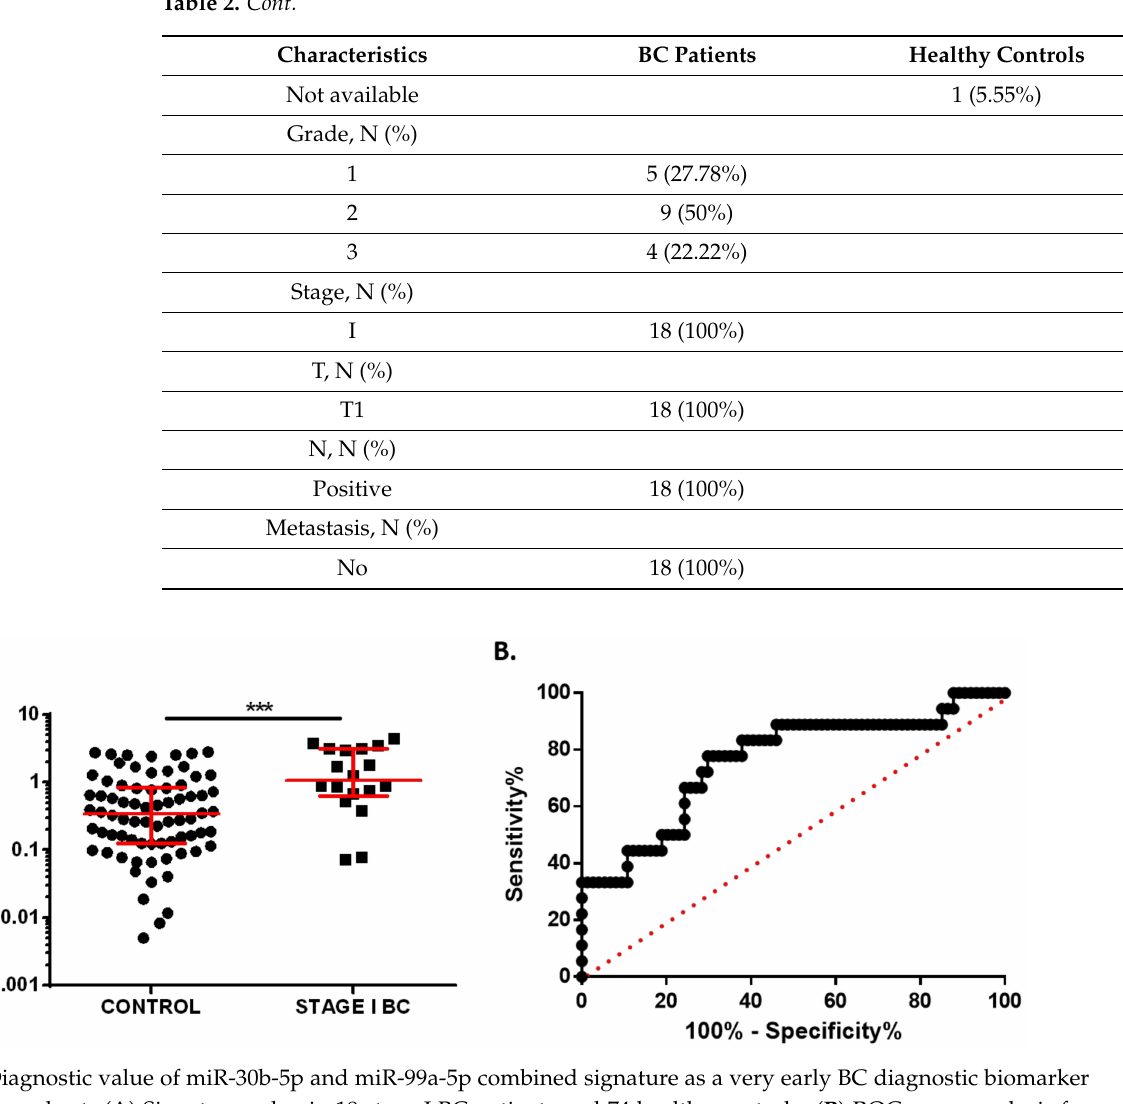
Figure 5. Diagnostic value of miR-30b-5p and miR-99a-5p combined signature as a very early BC diagnostic biomarker in validation cohort. ( A ) Signature value in 18 stage I BC patients and 74 healthy controls. ( B ) ROC curve analysis for combined signature in stage I BC patients. Red lines represent median ± interquartile range. *** p <